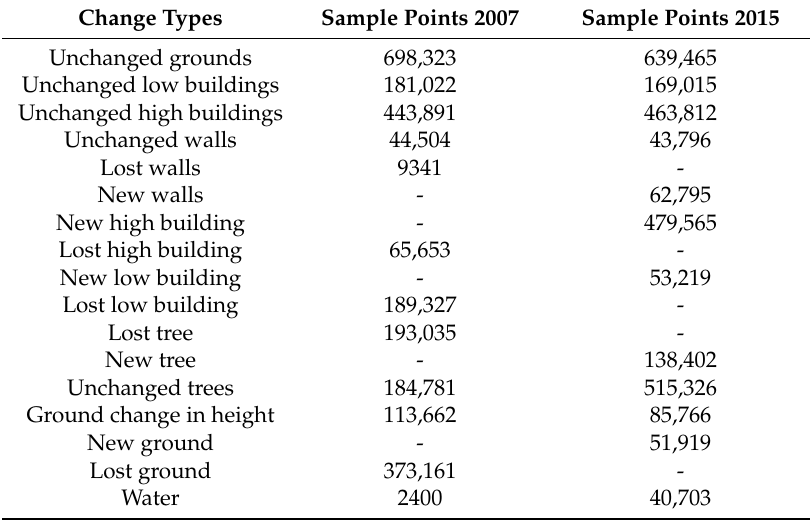
Table 3. Sample points of different change types in 2007 and 2015 datasets.